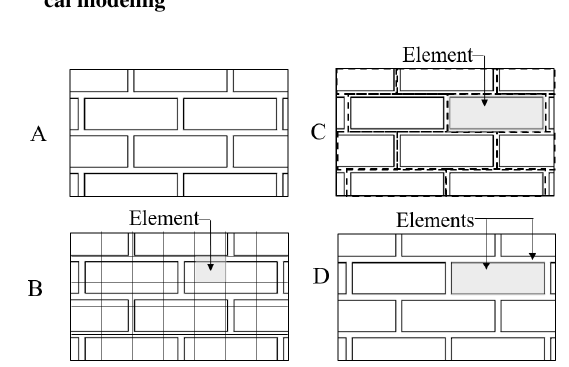
Figure 2. Subterranean foundation wall of the Baptistery di San Giovanni showing cracks